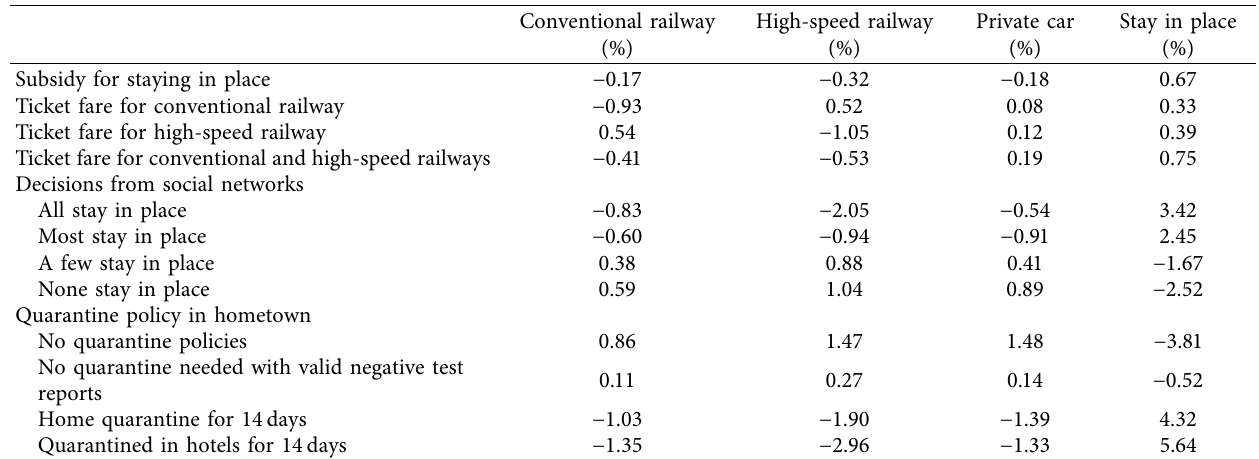
Table 5: Policy analysis based on the fnal